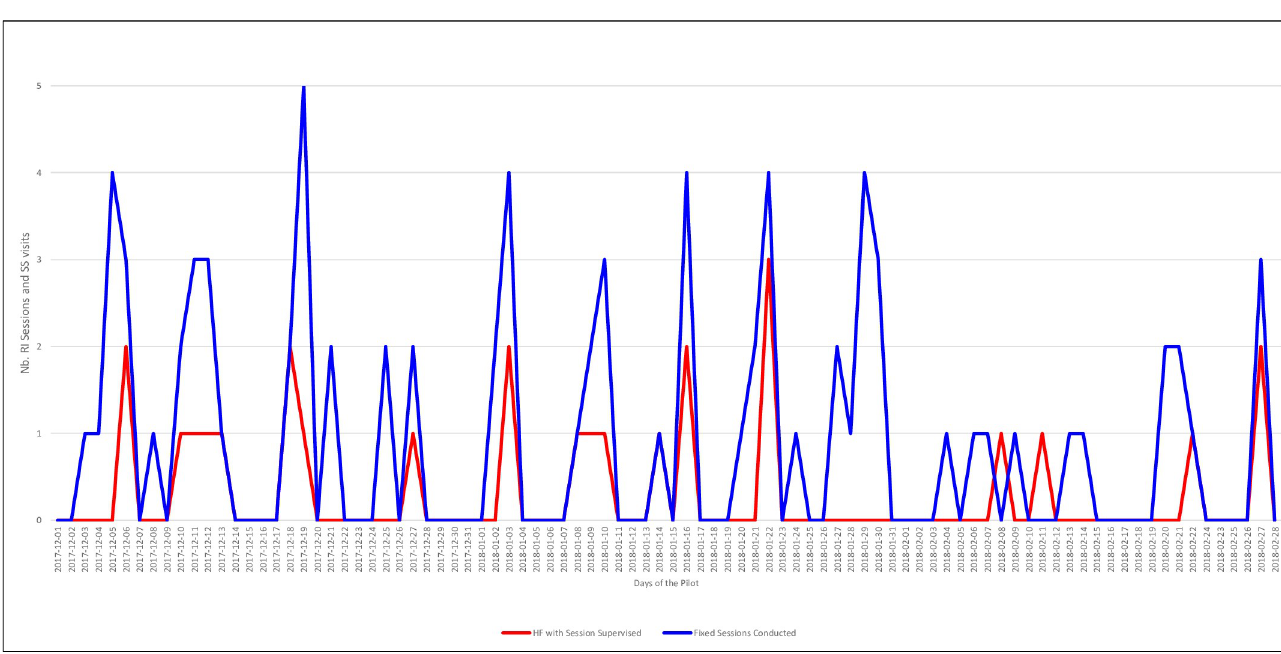
Fig 7. Number of fixed-post RI sessions reportedly conducted vs. number of those sessions that received supportive supervision, per day.